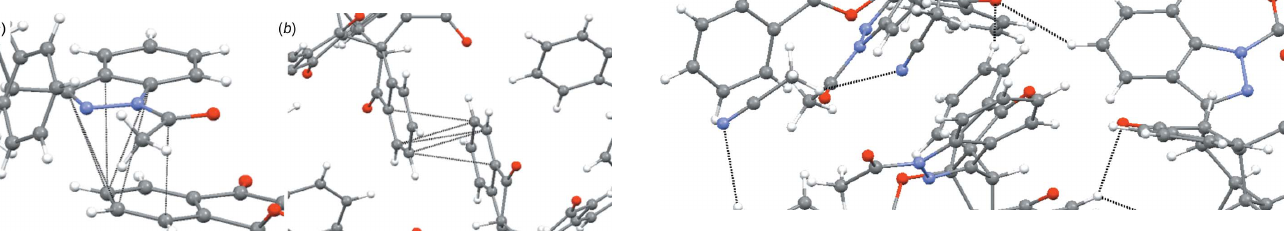
Figure 6 Part of the C—H (cid:2)(cid:2)(cid:2) O C bonding pattern between molecules of the title compound and also part of the C—H (cid:2)(cid:2)(cid:2) N C bonding pattern between the acetonitrile